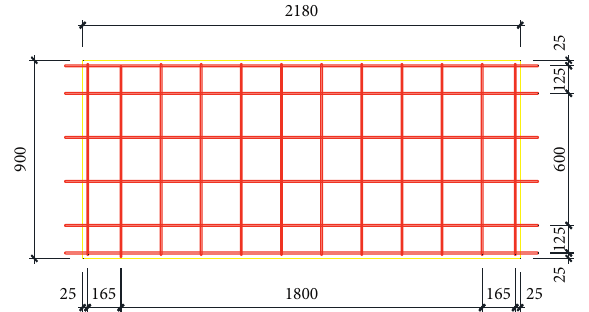
Figure 2: Illustration of the reinforcement of the composite slab.